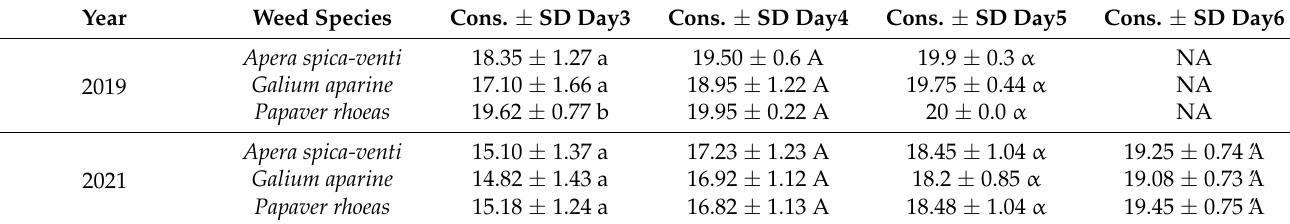
Table 2. Average cumulative consumption (20 initial seeds card-1) ( ± SD N = 40 for one species in one year) of the assessed weed species after 3–6 days of exposure to seed predation inside the winter wheat field and in the adjacent SNH, in 2019 and 2021 Gödöll˝o,